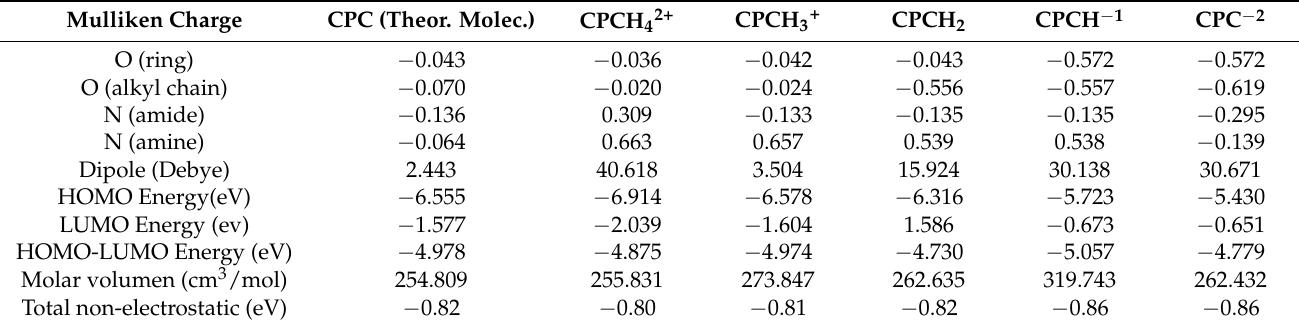
Table 2. Mulliken charge, molecular dipole, molar volume and total non-electrostatic energy of different forms of CPC. Mulliken Charge CPC (Theor.